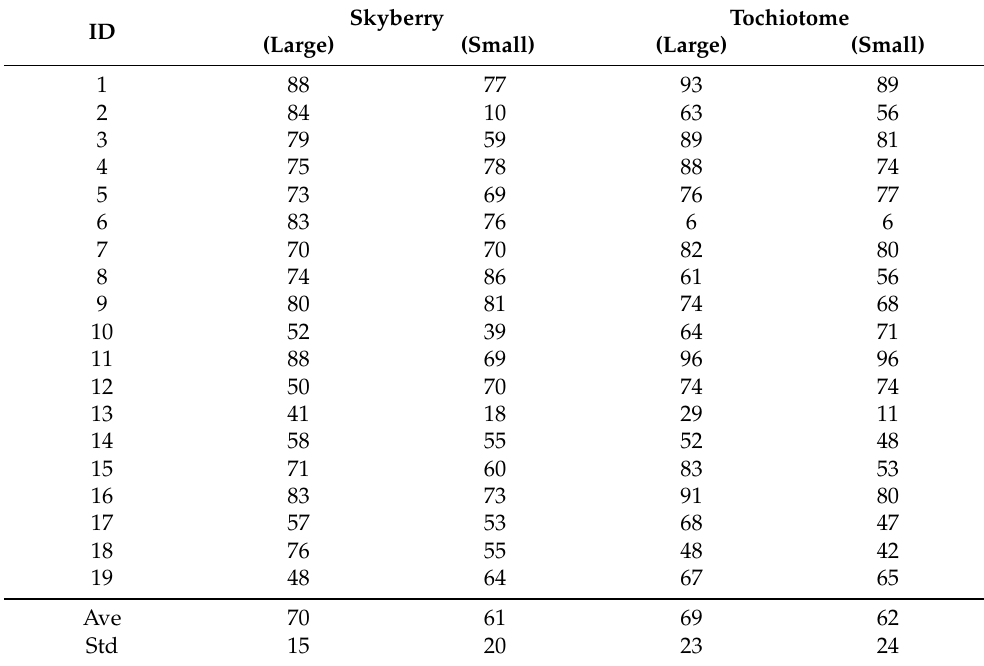
Table 1. The VAS , which is a score in millimeters of each strawberry evaluated by each participant. “Ave” and “Std” mean the average and standard deviations of the VAS,